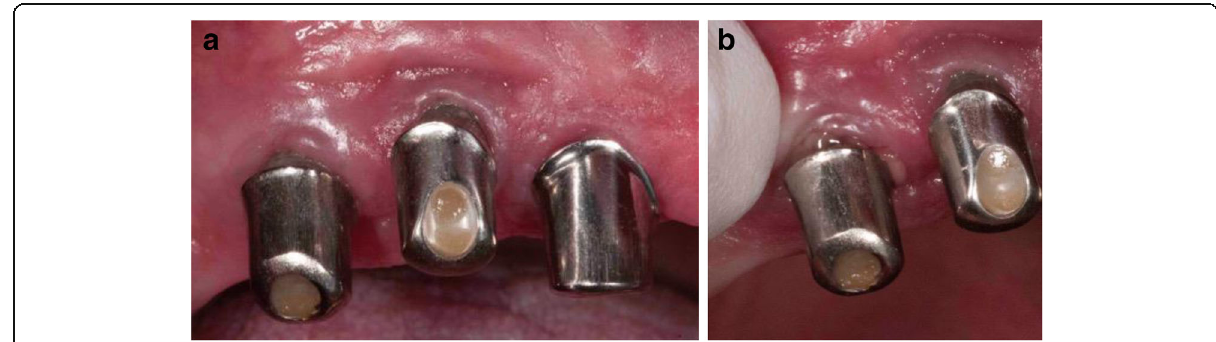
Fig. 8 a The clinical findings 16 years after insertion of the superstructure showed at the implants with primary crowns slight recessions of the soft tissue and the keratinized mucosa was > 1 mm. b The implant in region 14 showed suppuration on light